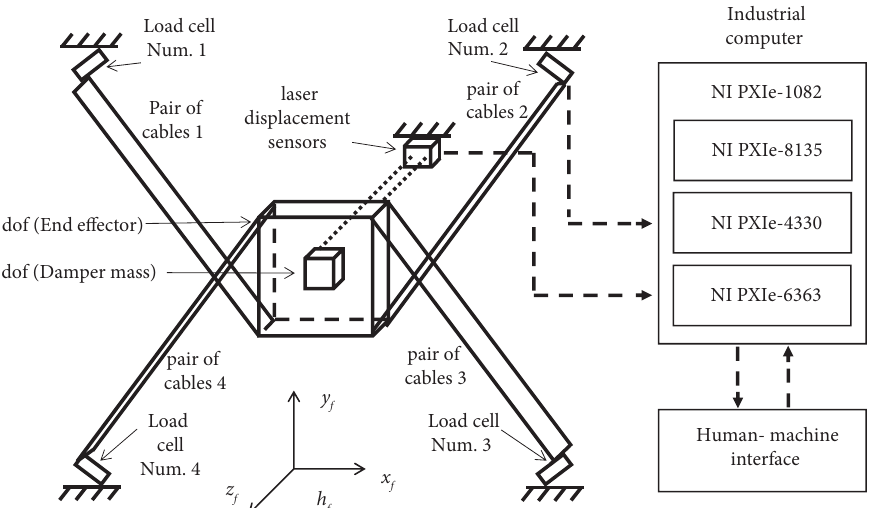
Figure 5: Block diagram of the experimental setup.